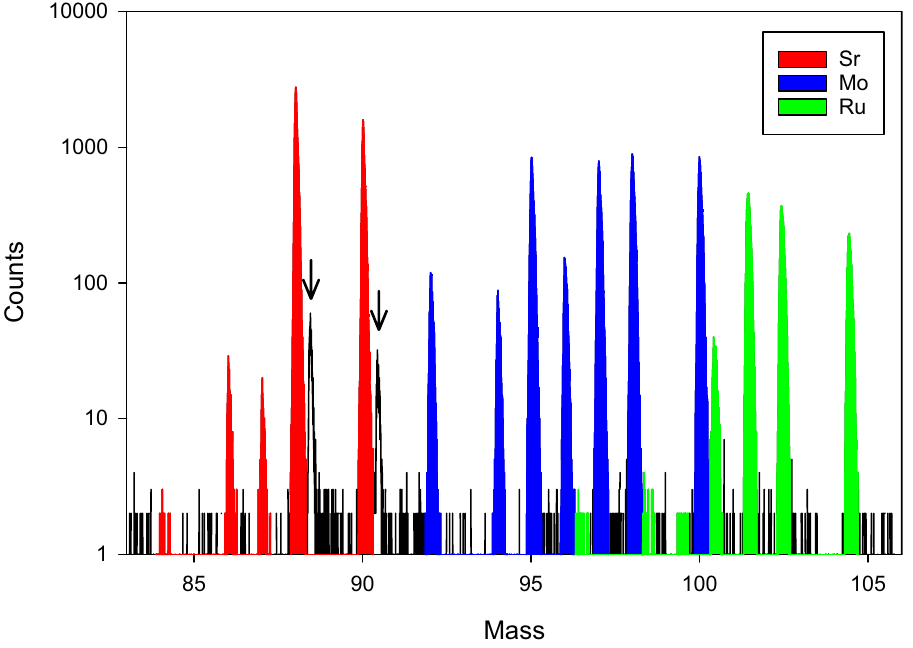
Figure 2. RIMS spectrum showing Sr (red), Mo (blue) and Ru (green) isotopes in spent nuclear fuel. The arrows indicate Sr ionized non-resonantly by the Ru lasers, which were delayed relative to the Sr and Mo lasers (see text).